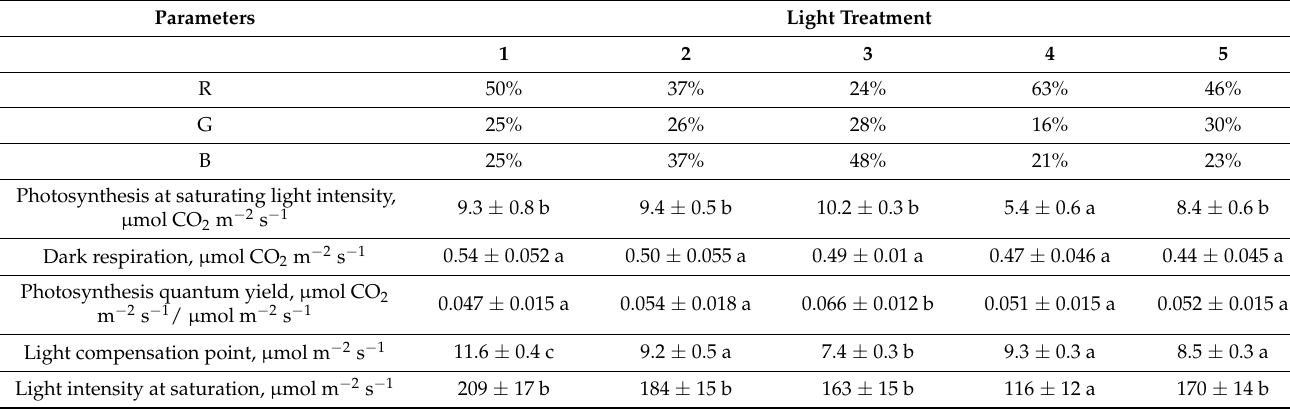
Figure 12. Light response curves of raspberry plants grown under various red (R)–green (G)–blue (B) light ratio. Means ± standard error (SE); means followed by the same letter were not different at p ≤ 0.05. Treatment 1—50% R, 25% G, 25% B; Treatment 2—37% R, 26% G, 37% B; Treatment 3—24% R, 28% G, 48% B; Treatment 4—63% R, 16% G, 21% B; Treatment 5—46% R, 30% G, 23% B. Table 3. Light response curve parameters in raspberry plants grown under various red (R)–green (G)–blue (B) light ratios. Standard error (SE); means followed by the same letter were not different at p ≤